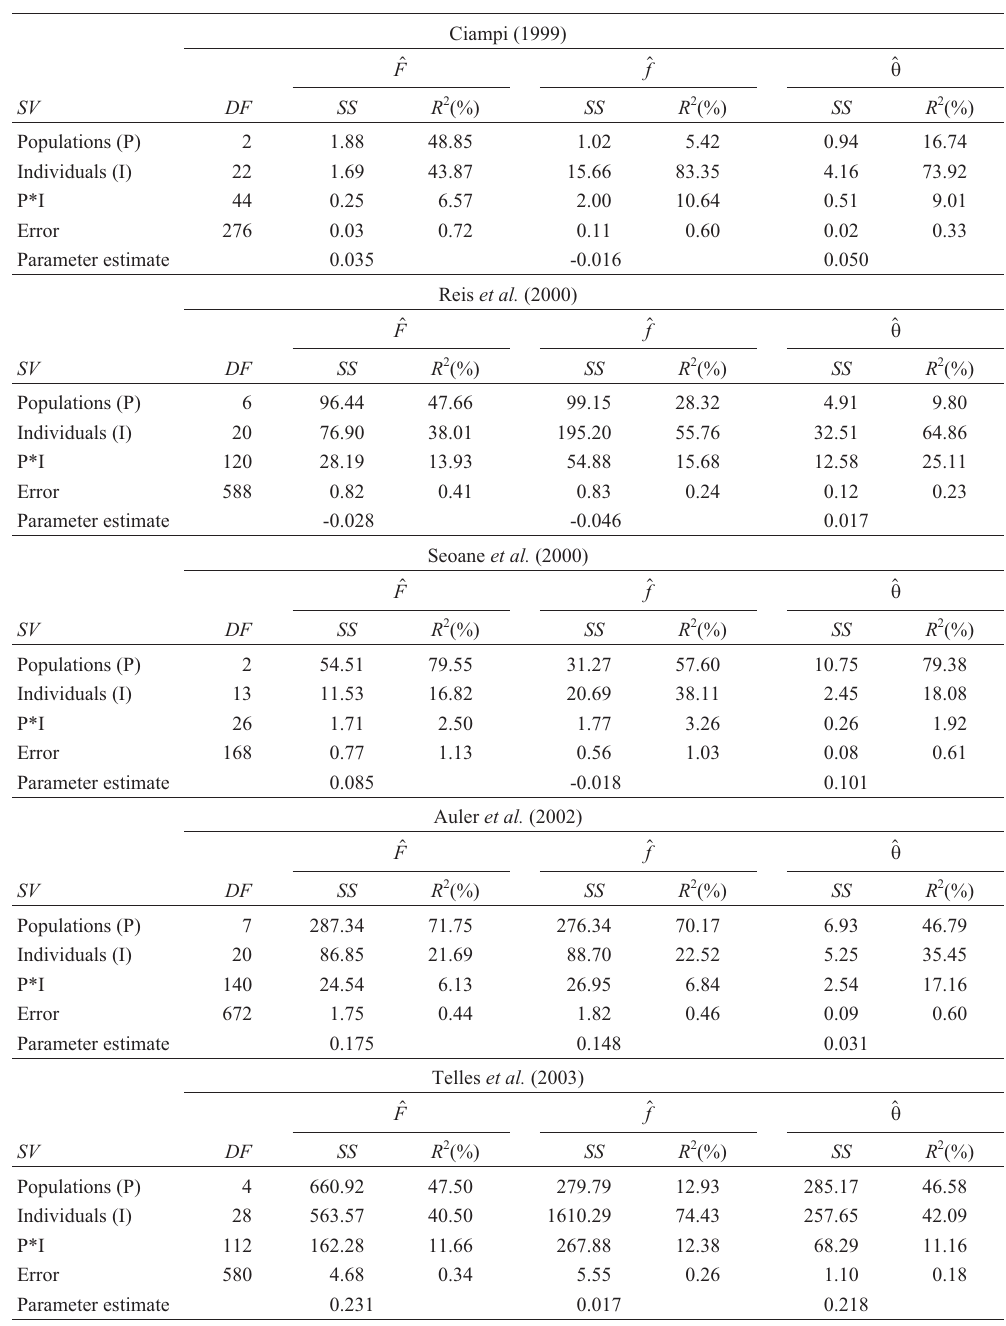
Table 1 - Analysis of variance of bootstrap variance estimates of a (cid:1) F , b (cid:1) f , c (cid:1) (cid:4) , obtained from joint resampling of individuals (I) and populations (P), and the coefficient of determination ( R 2 ) of the sources of variation. Data sets provided by several